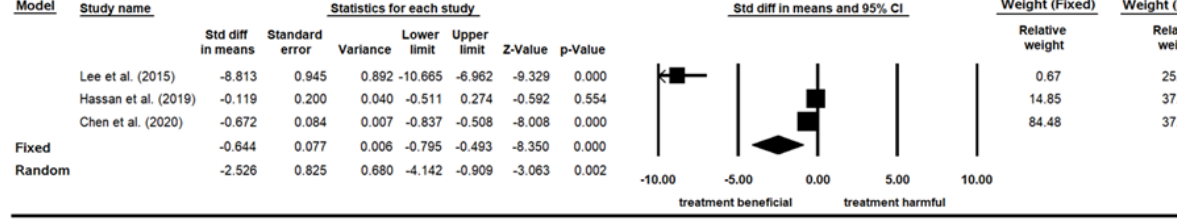
Table 10. Original data of the studies examin ing the influence of indoor plants on EEG α waves.